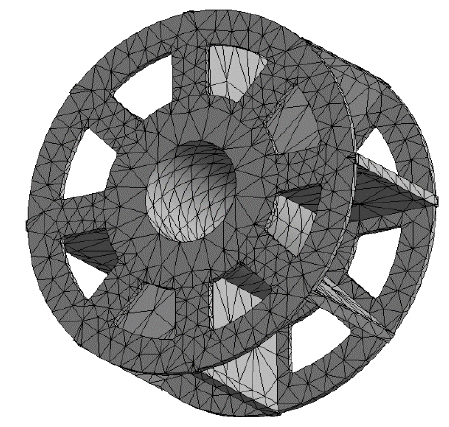
Figure 10. Mesh division of the rotor mechanism.